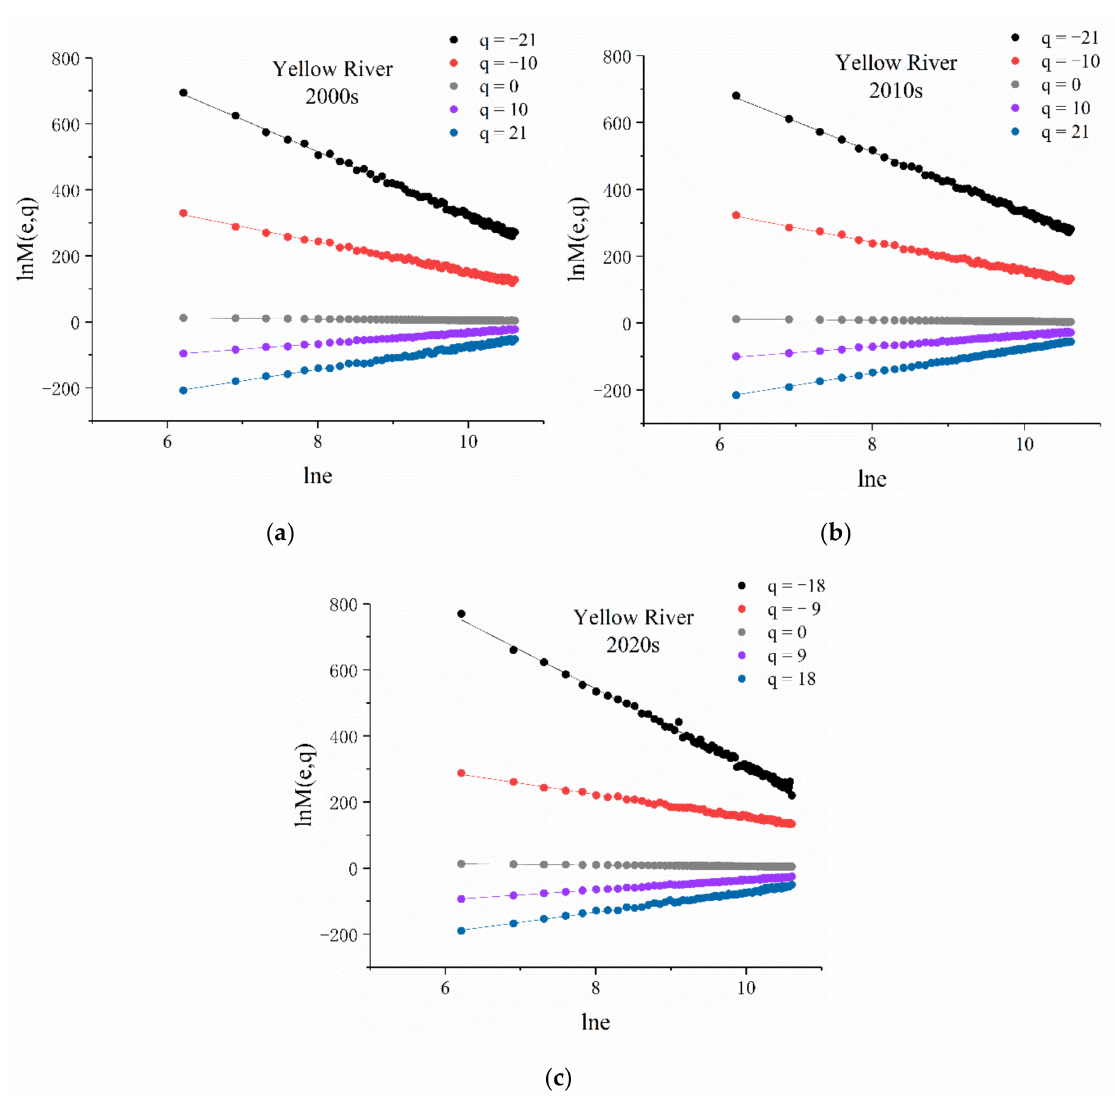
Figure 5. The relationship between ln e and ln M ( e , q ) of the Yellow River Basin in the ( a ) 2000s, ( b ) 2010s, and ( c )